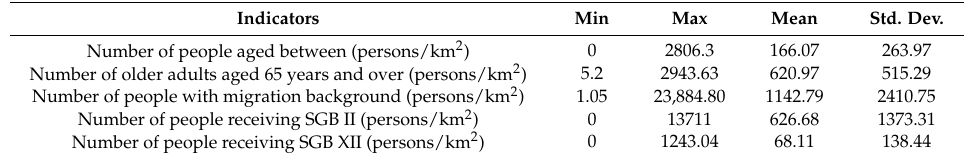
Table 6. Descriptive statistics for indicators of social vulnerability at statistical sub-districts